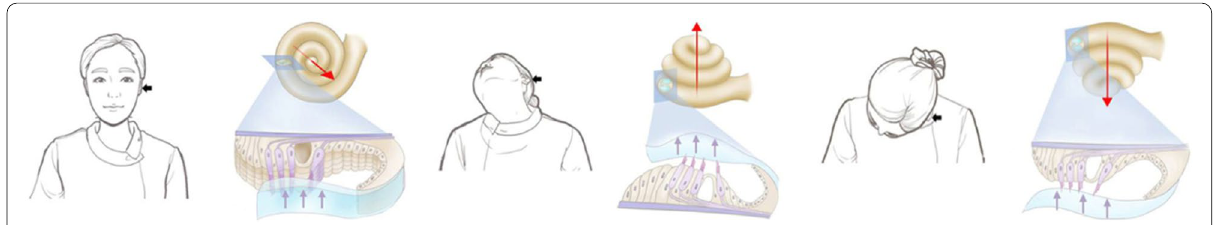
Fig. 3 Different head positions in positional audiometry